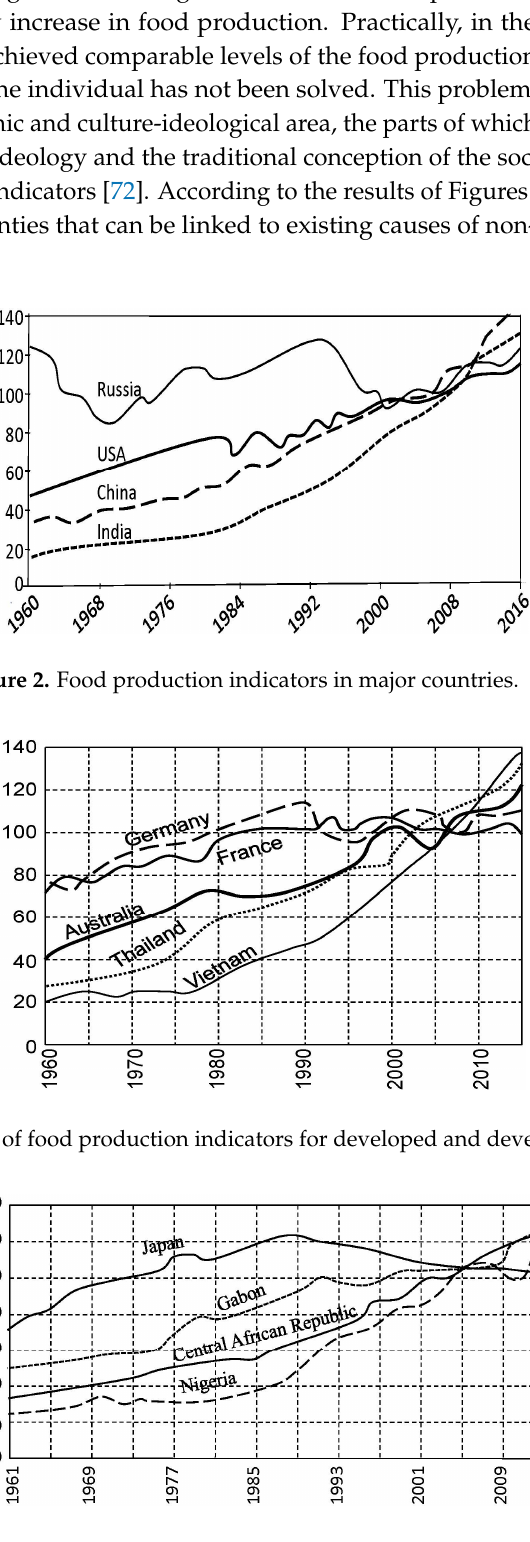
Figure 5. Birth rates and mortality dependencies on the Human Development Index adopted by the countries. Under the premise of peaceful coexistence, the problem of population survivability lies in providing food to those who have to look after the dependencies of global distribution of food and water supplies on the path of globalization. Figure 6. An interdependence of the Food Production Index (FPI) and Human Development Index (HDI) for the different countries.